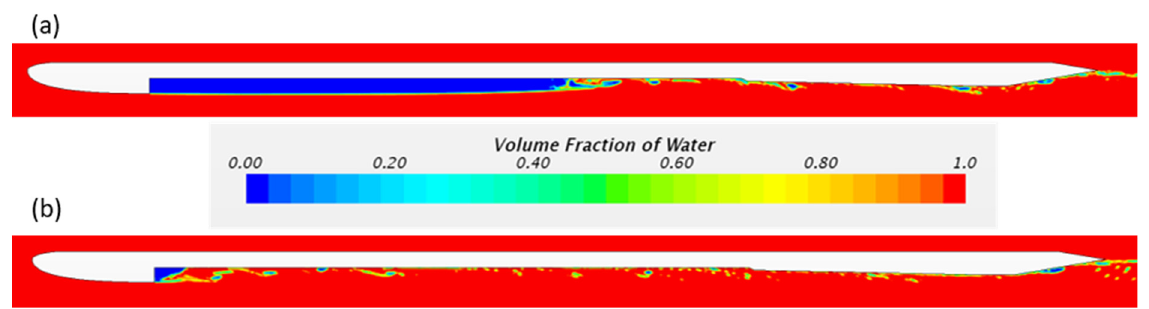
Figure 7. Air cavity in the collapsing process when air supply was reduced from 𝑞 = 0.016 to 0.010. Cavity shapes: ( a ) intermediate state, ( b ) close to the completely collapsed state.